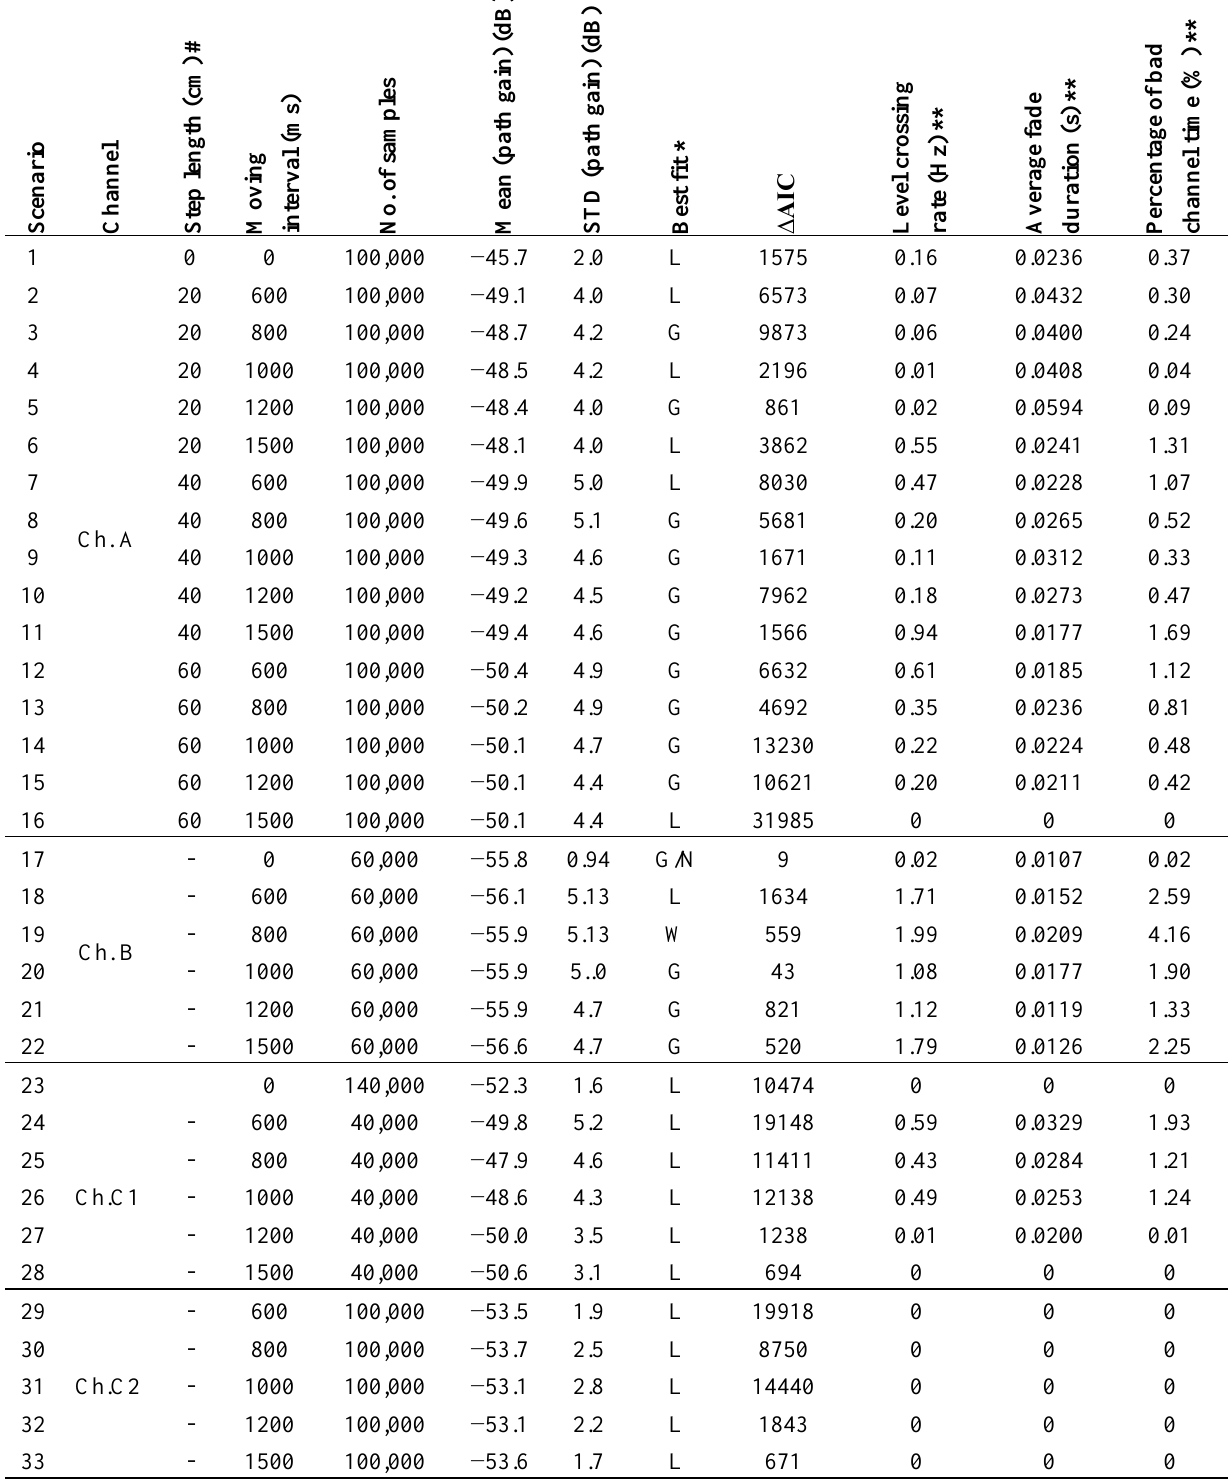
Table 1. Measurement design and statistical analysis of the measurement